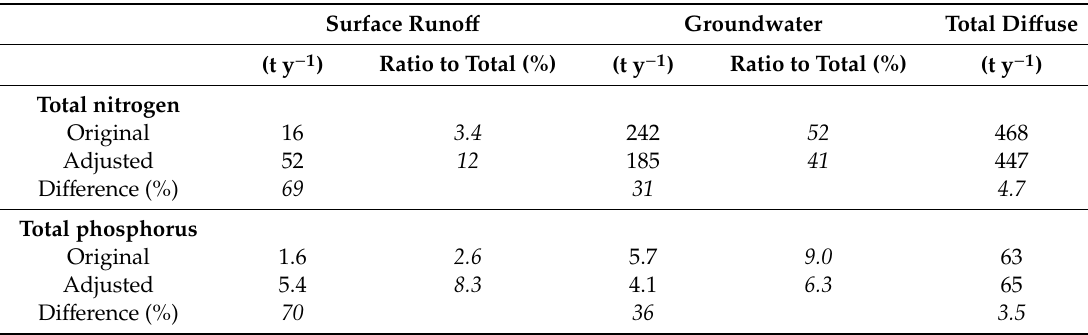
Table 8. Total nitrogen and total phosphorus loads in unique pathways before and after the correction of the groundwater flow